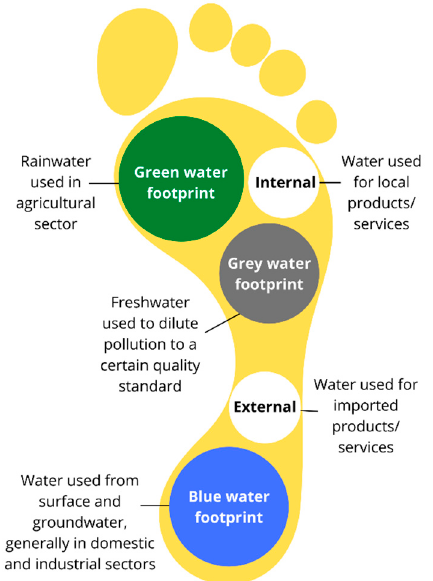
Figure 3. Different components of water footprint including green water footprint, blue water footprint, grey water footprint, internal water footprint, and external water footprint.